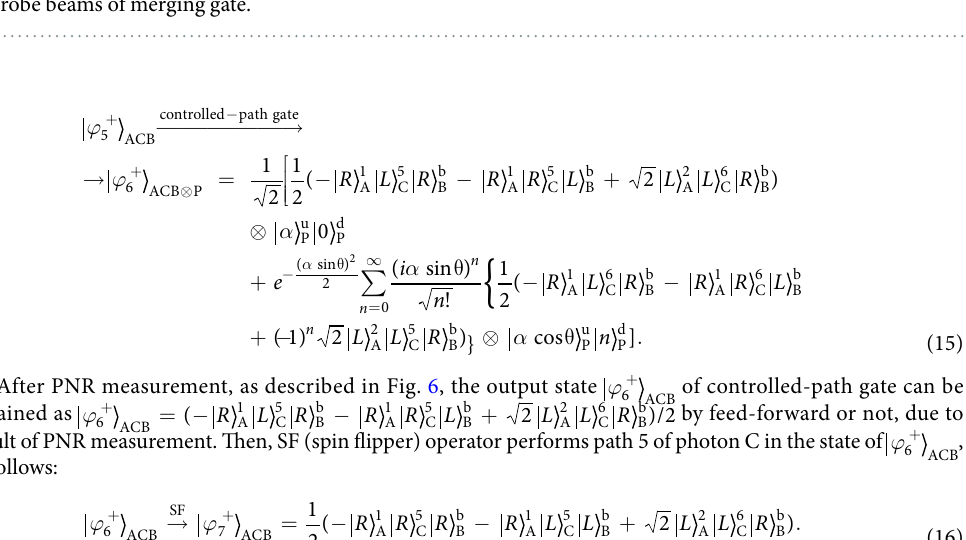
Figure 6. CNOT gate: This gate is constructively the same as controlled-Hadamard gate in Fig. 4. The SF operator between controlled-path and merging-path gates plays the role of NOT gate. Similar to controlled- Hadamard gate, probe beams (coherent state: α ) used in controlled-path gate can also be recycled to be utilized as probe beams of merging